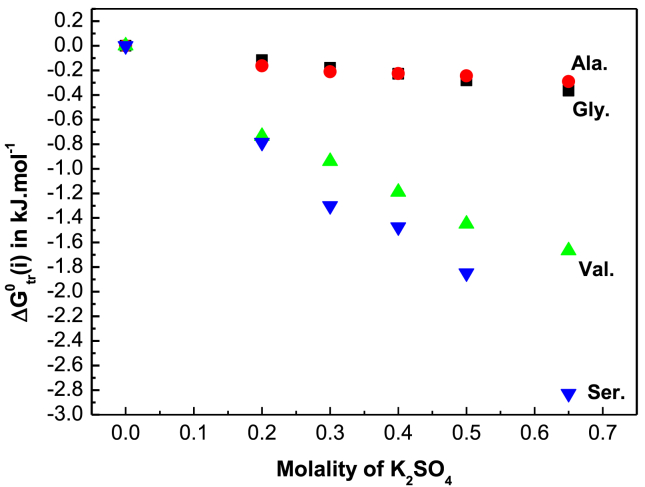
Variation of ΔGtr0(i)in kJ·mol−1with molality of K2SO4 in aqueous K2SO4 solution for glycine (■), D,L-alanine (●),D,L-serine (▼) and D,L-nor-valine (▲) at 298.15 K.